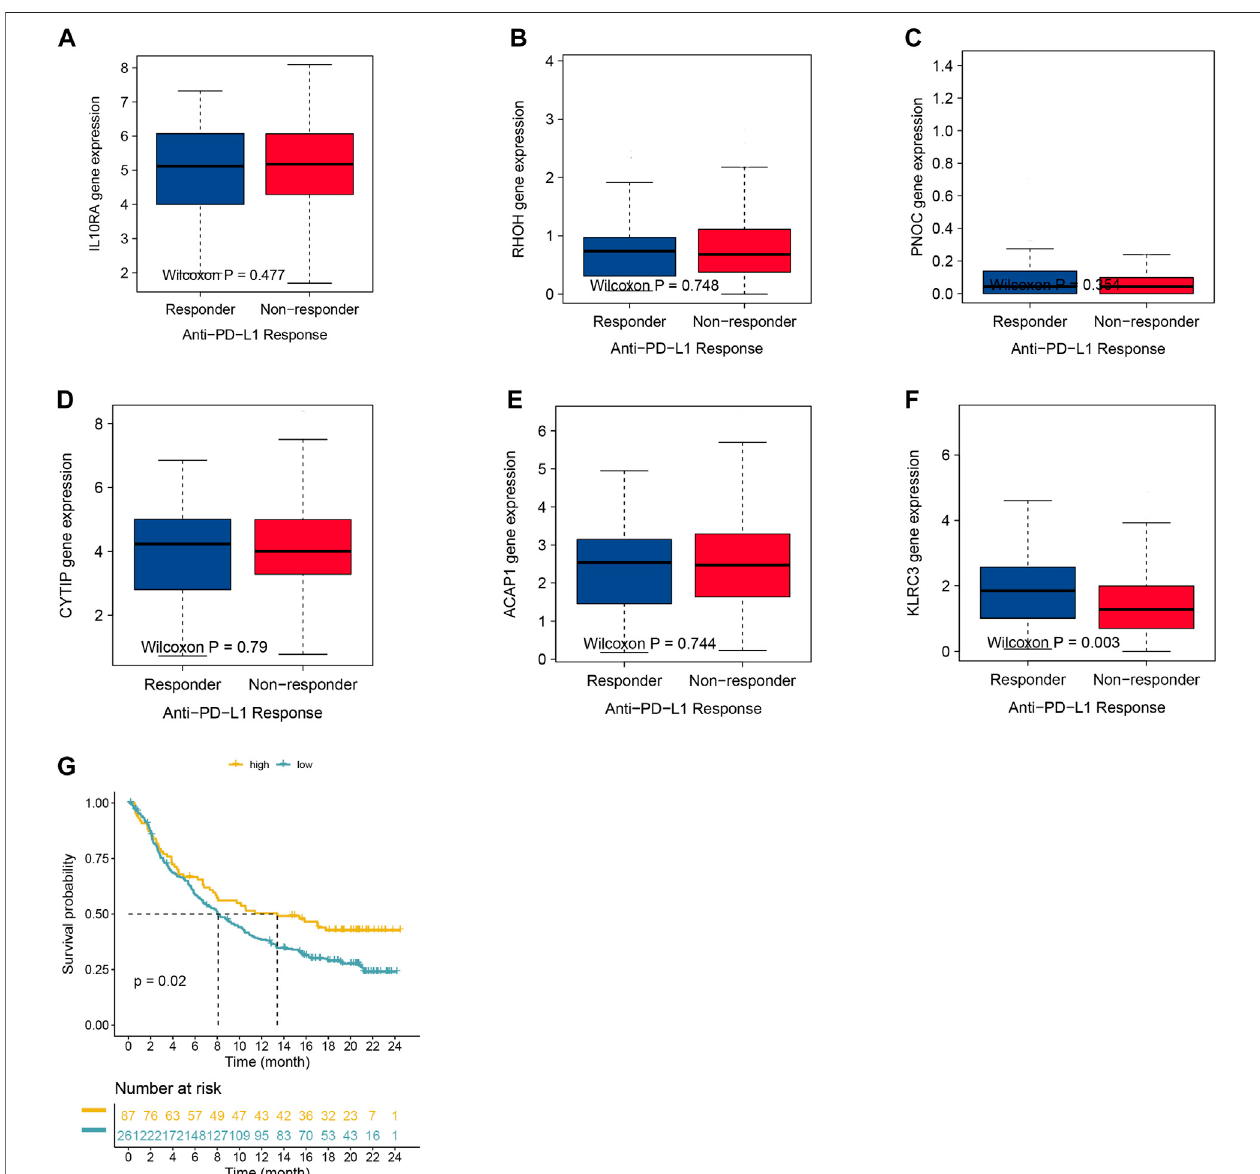
FIGURE 6 | (A – F) Expression of selected genes with varying anti-PD-1 responses. (G) Kaplan – Meier graphs of KLRC3 expression in the IMvigor210 cohort.